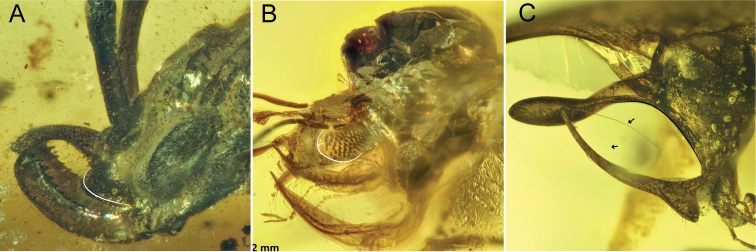
Cranial armaments of †HaidomyrmecinaeA †Chonidris
insolita female, dorsolateral oblique (FANTWEB00033, AntWeb: Vincent Perrichot) B †Aquilomyrmex
huangi female, ventrolateral oblique (FANTWEB00023, AntWeb: Vincent Perrichot) C †Linguamyrmex
rhinocerus, female, lateral (FANTWEB00016, AntWeb: Vincent Perrichot).